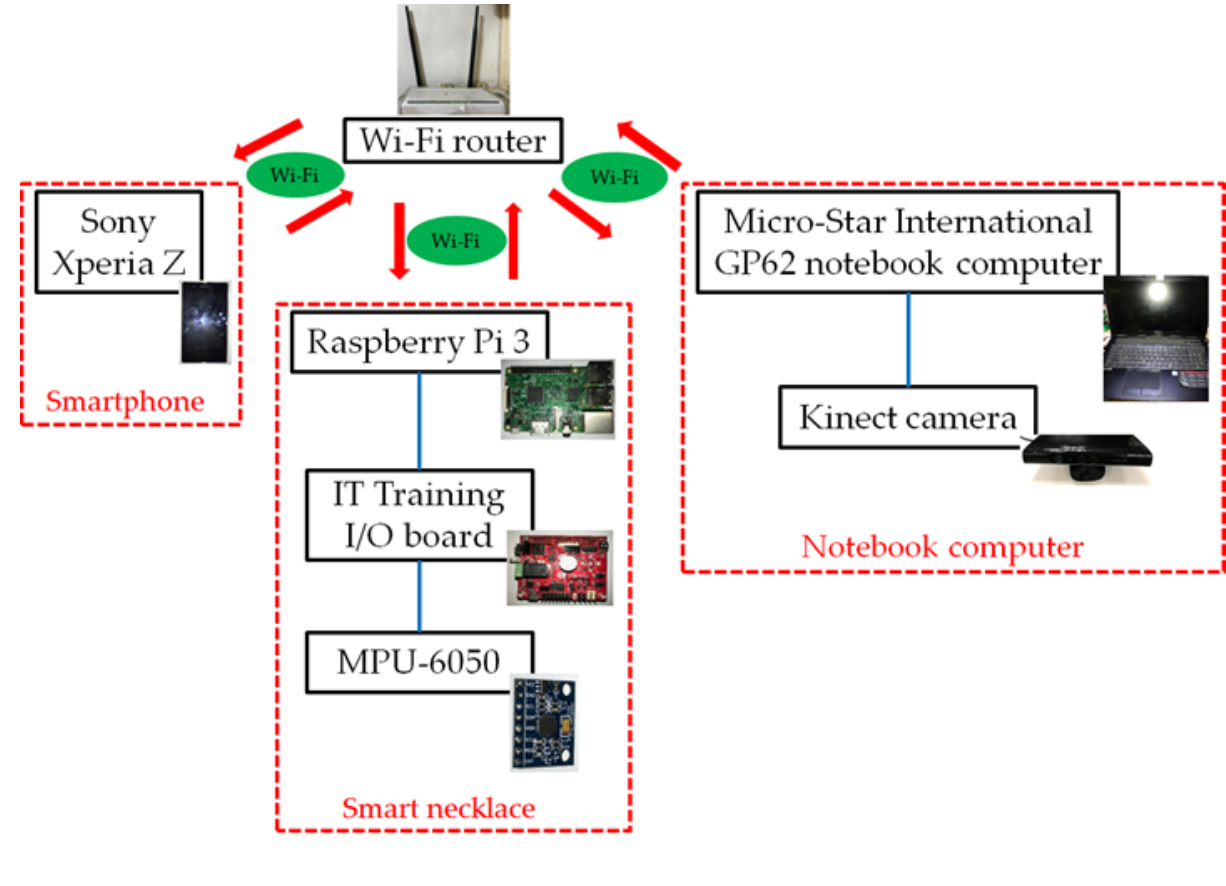
Figure 1. Hardware architecture of the overall